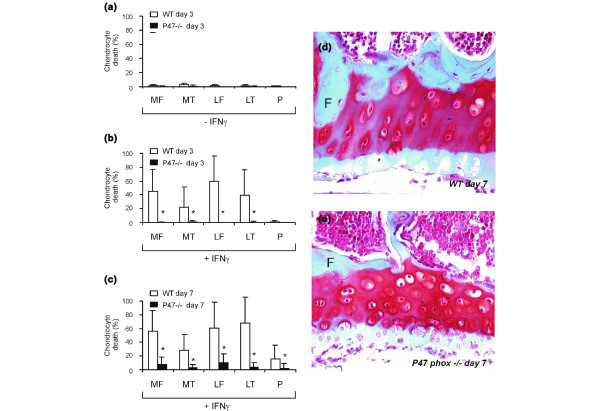
Chondrocyte death in cartilage layers of inflamed knee joints of p47phox-/- and wild-type mice). At day 3 after ICA induction (a) and at day 3 (b) and day 7 (c) after IFNγ-stimulated ICA. Chondrocyte death was determined in various cartilage layers of the knee joint (LF, lateral femur; LT, lateral tibia; MF, medial femur; MT, medial tibia; P, patella). Chondrocyte death was expressed as a percentage of empty lacunae. Note that without IFN-γ no chondrocytes were observed. At day 7 after IFNγ-stimulated ICA, chondrocyte death was clearly present in wild-type controls (d), whereas in p47phox-/- mice chondrocyte death was completely absent (e). Original magnifications ×400.